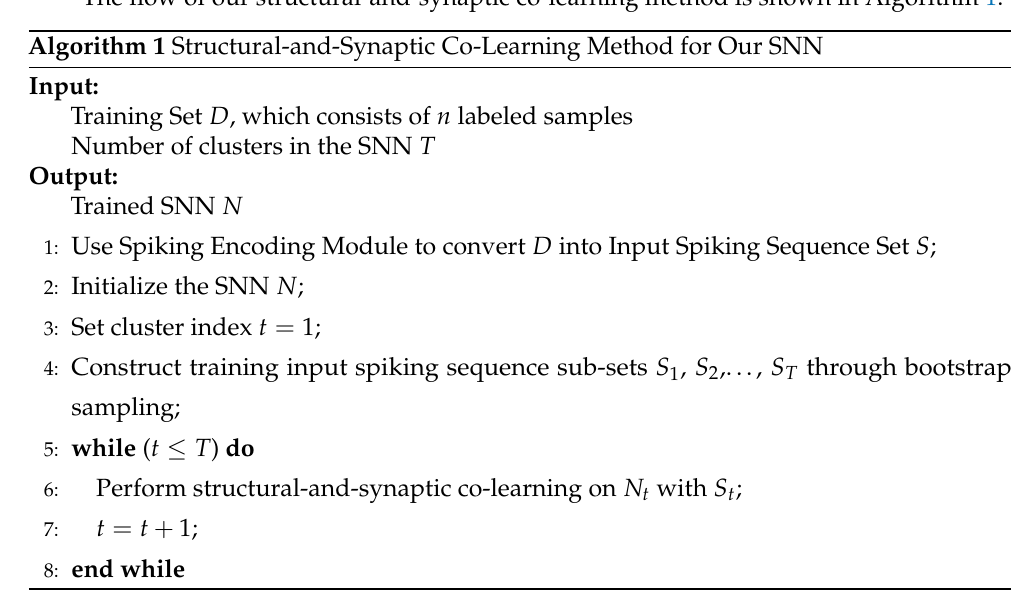
Algorithm 1 Structural-and-Synaptic Co-Learning Method for Our